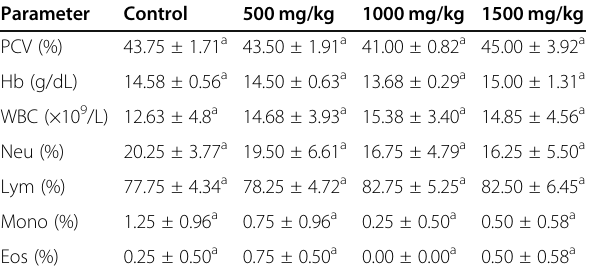
Table 2 Effect of ethanolic extract of Spondias purpurea leaf on haematological parameters in rats Parameter